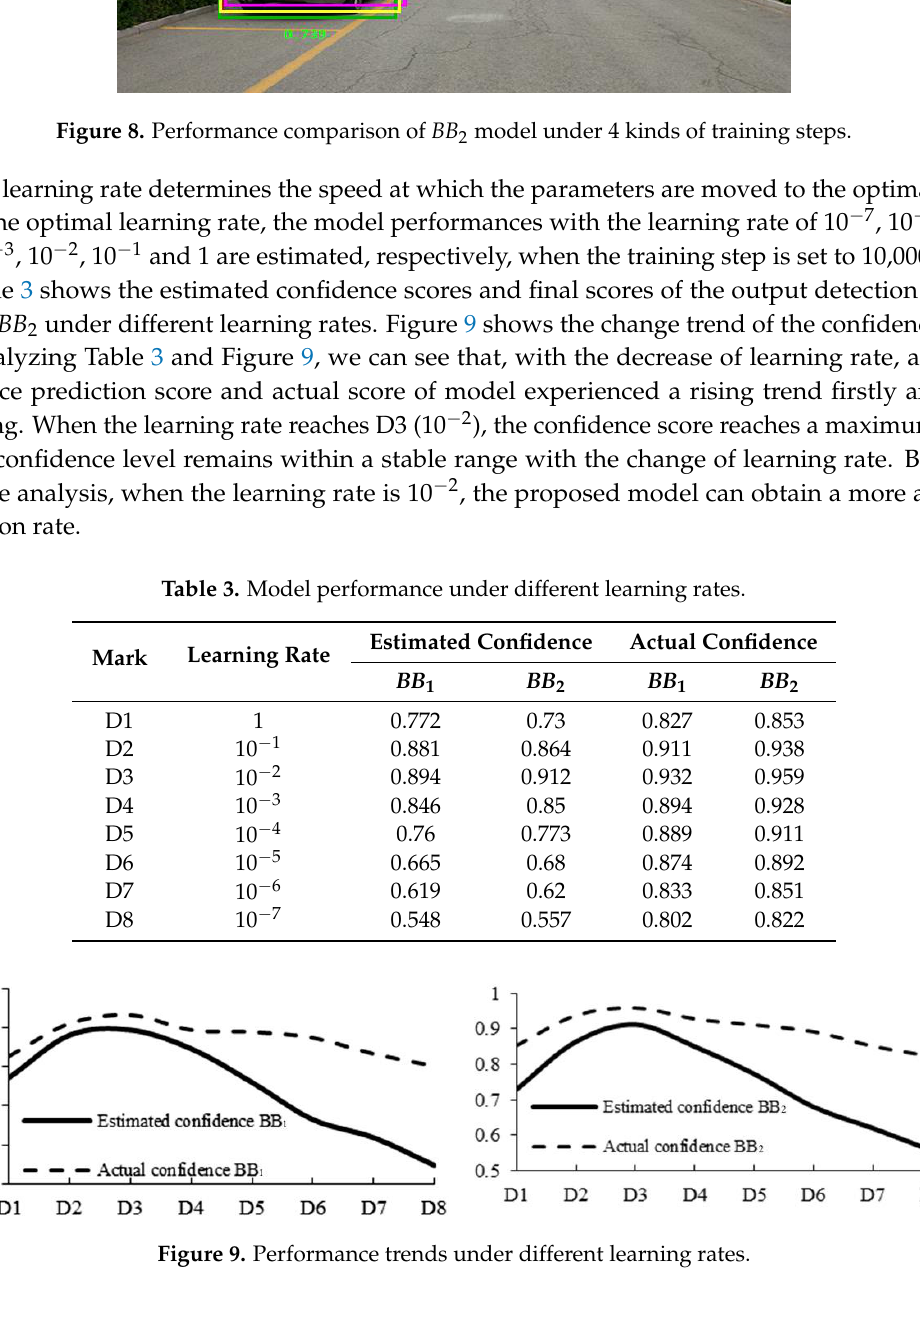
Figure 9. Performance trends under different learning rates.